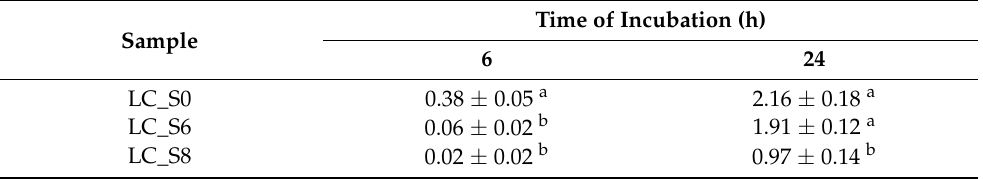
Table 1. Decrease in pH of MRS broth inoculated with cells of sonicated and not-sonicated Lacticas- eibacillus casei ATCC 393, after 6 and 24 h of incubation at 37 ◦ C. LC_S0: not-sonicated cells, control; LC_S6: treatment at 57 W with 50% DC for 6 min; LC_S8: treatment at 57 W with 50% DC for 8 min. Time of Incubation (h) Sample 6 24 LC_S0 0.38 ± 0.05 a